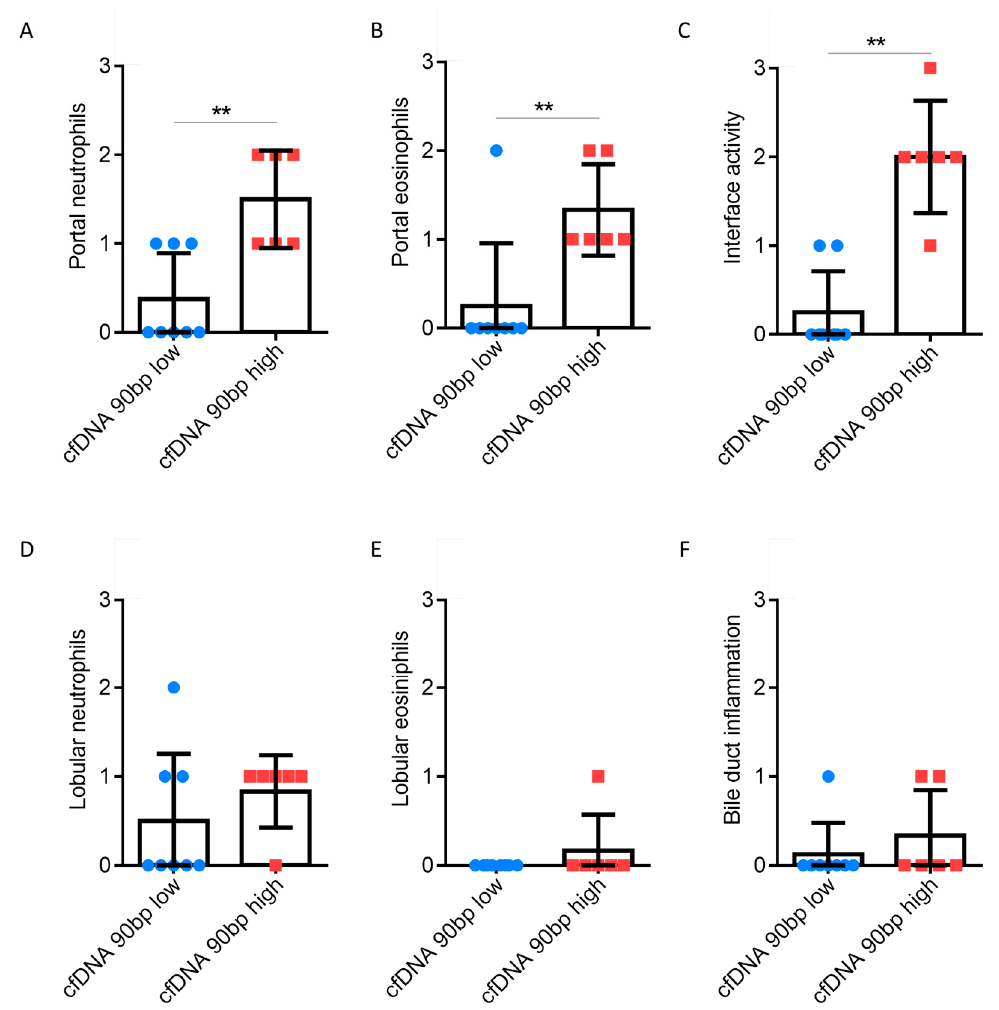
Figure 4. Evaluation of liver biopsies as part of clinical diagnostics based on haematoxylin and eosin staining. The presence and amount of neutrophils ( A , D ), eosinophils ( B , E ) was determined for patient groups with high and low cfDNA portal and lobular (L1PA2 element, 90 bp, LINE sequence, non-coding). Furthermore, interface activity ( C ) and bile duct inflammation ( F ) were determined. Samples with a rejection > BANFF 1 were excluded from the analysis. Mann-Whitney U test; ** p <